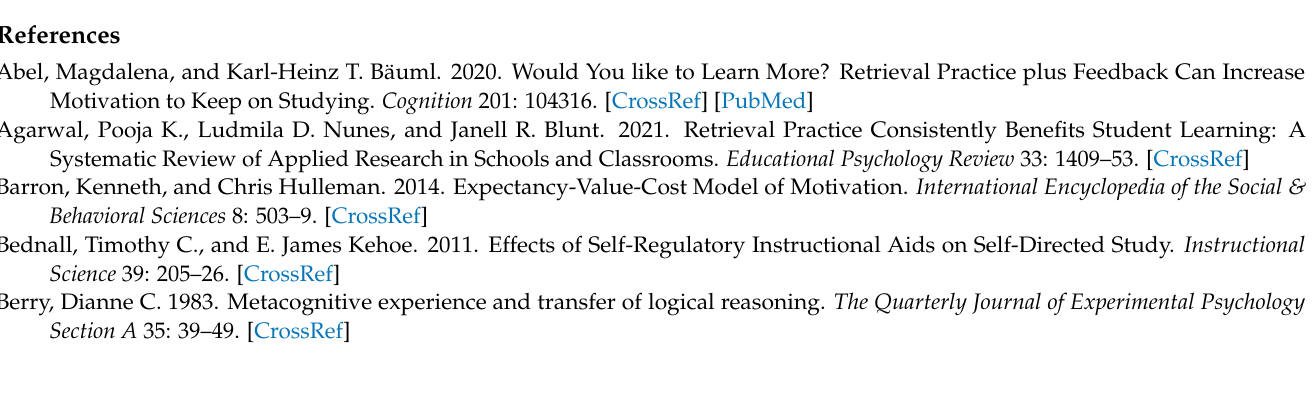
Table S4: Wording of the Vignettes in Study 2. Table S5: MANOVA Results Between Vignettes and Performance and Learning Ratings. Table S6: Descriptives for Ratings on Performance and Learning per Vignette. Table S7: Descriptives for Ratings on Strategies Similarities. Table S8: ANOVA and Pairwise Comparisons: Similarity of Vignette Strategies to Own Study Behavior. Table S9: Chi- square Goodness-of-fit Tests: Did the Reported Barriers Differ Across Exams? Table S10: Coding of Open-Ended Responses for Top Barrier to Using Effective